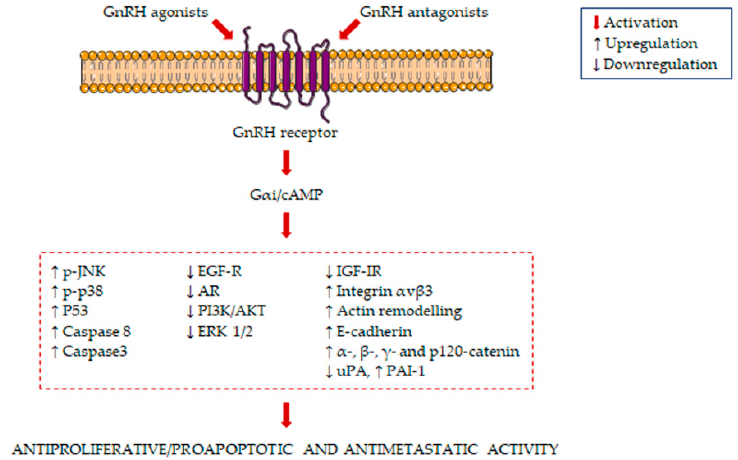
Figure 1. Molecular mechanisms underlying the antiproliferative / proapoptotic and antimetastatic activity of gonadotropin-releasing hormone receptors (GnRH) agonists and antagonists in prostate cancer (PCa) cells. GnRH agonists and antagonists bind to the GnRH receptor in PCa cells, leading to the activation of G α i / cAMP. This is followed by the induction of several antiproliferative / proapoptotic and antimetastatic pathways.